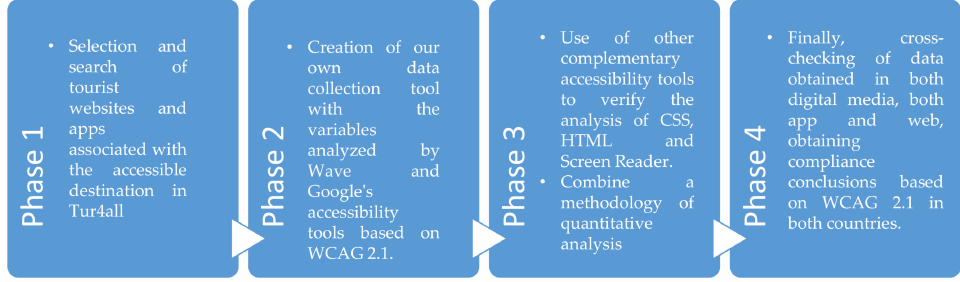
Figure 4. Selection, creation, complementary and checking (SCCC) model. Source: Own